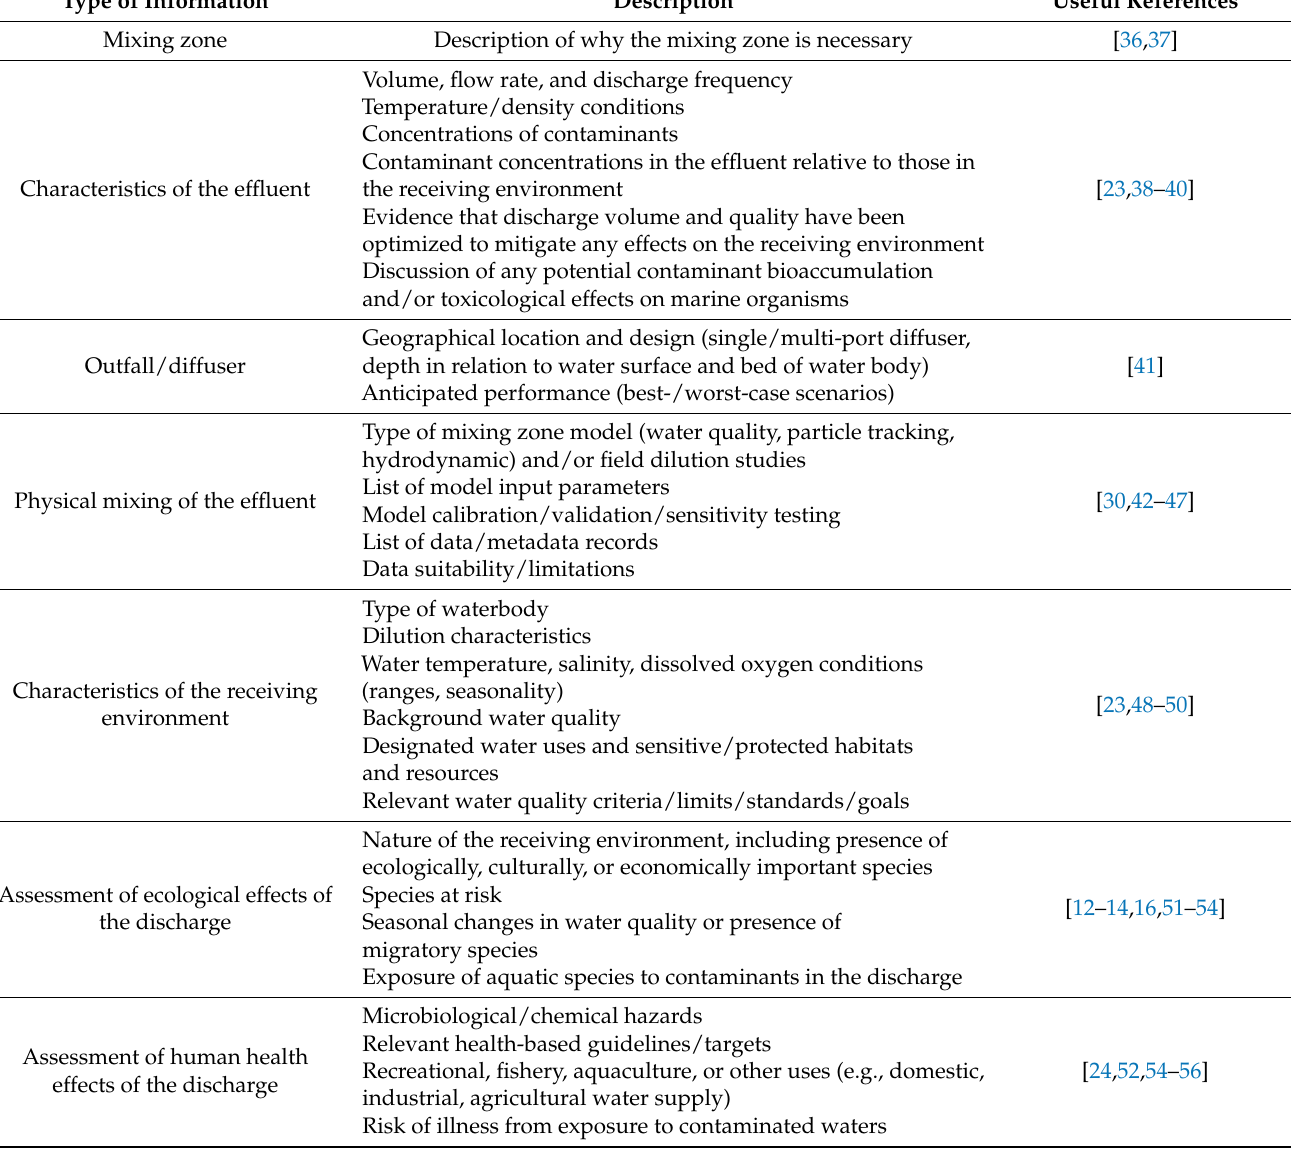
Table 2. List of information normally used to determine a discharge mixing